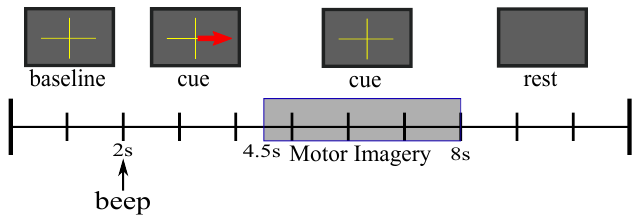
Figure 1. Extraction of MI for each